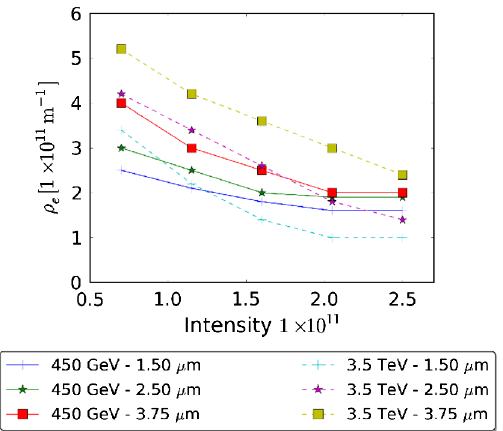
FIG. 16. Instability threshold values for the straight section for 450 GeV and for 3.5 TeV and different transverse emittances.